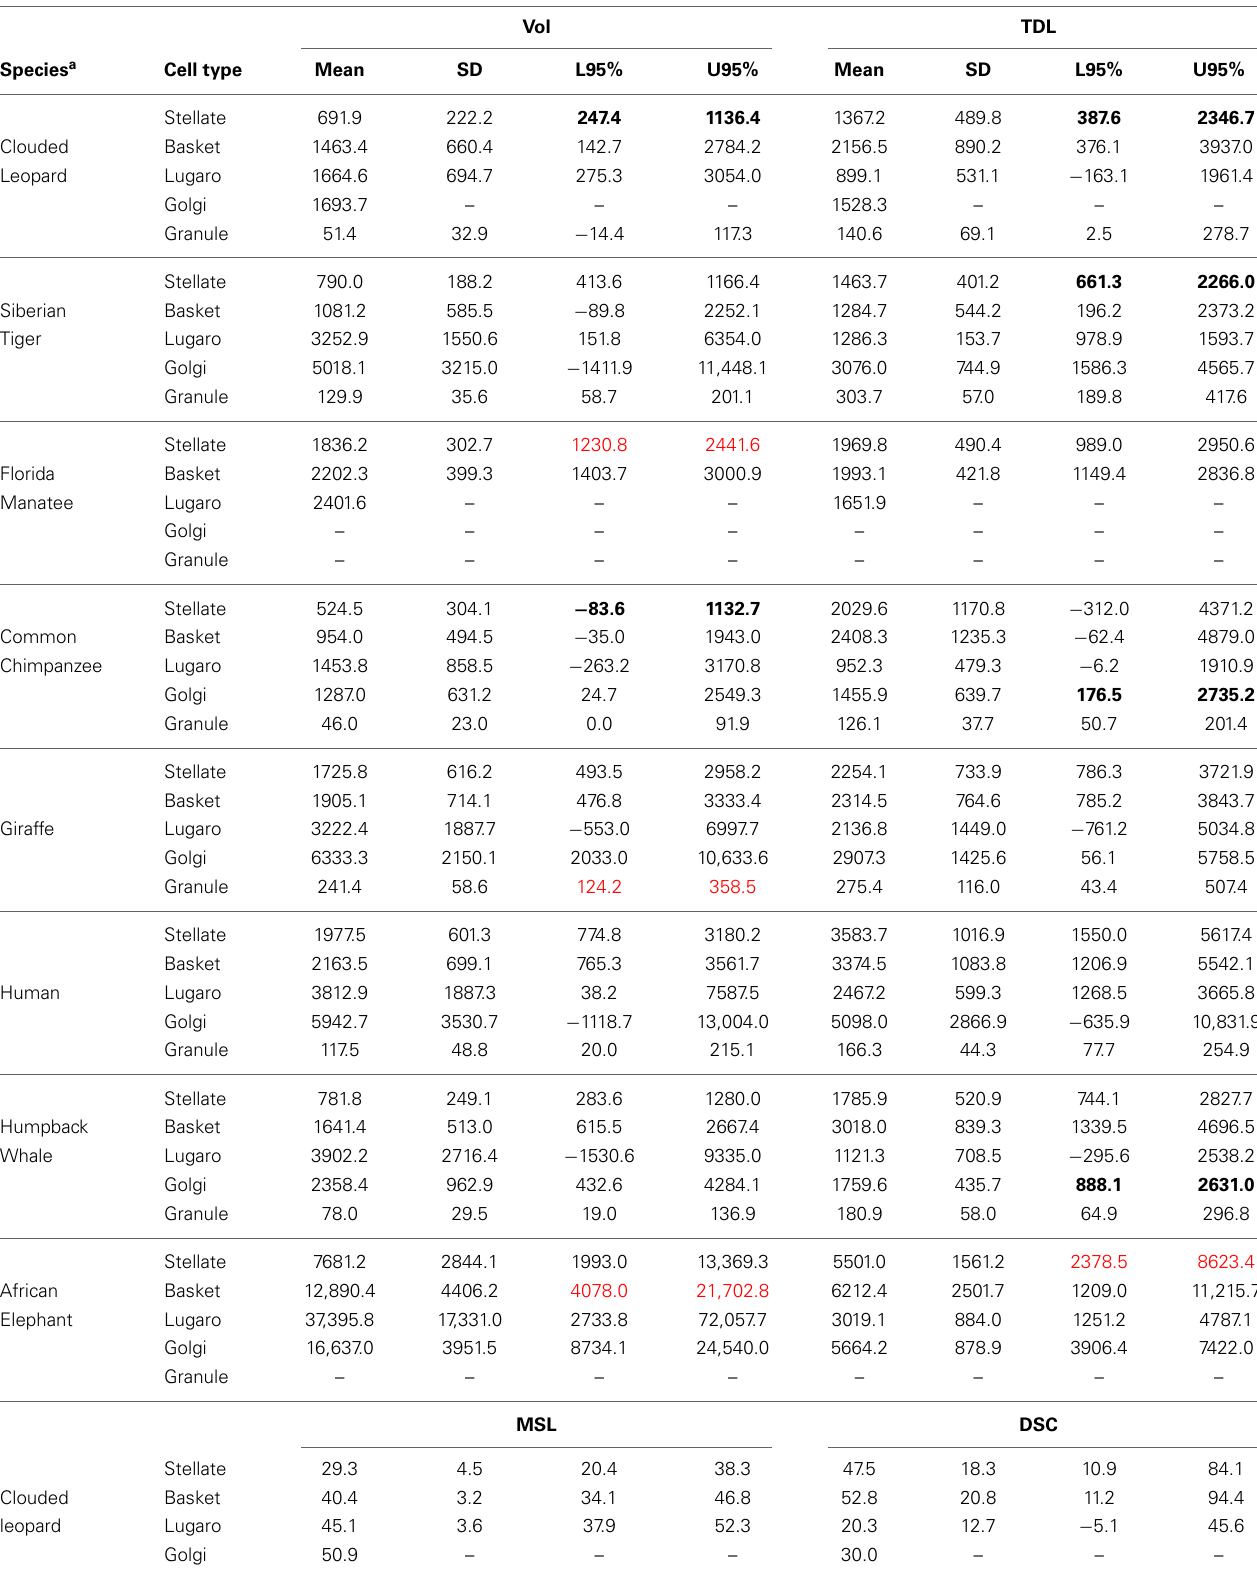
Table 2 | Dendritic measures and soma size for each neuronal type across species.